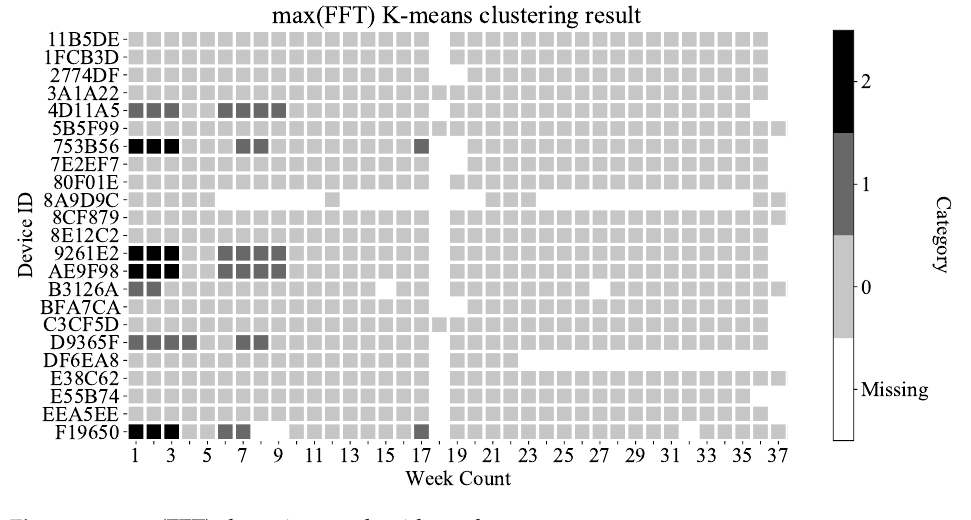
Figure 26. max(FFT) clustering result with week count.